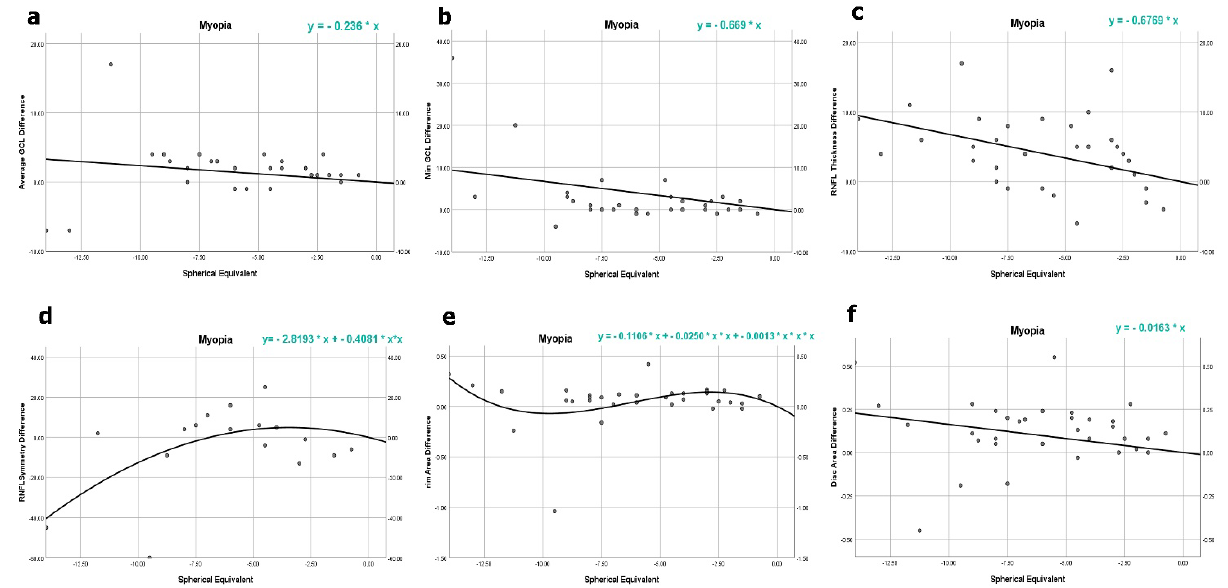
Figure 1. ( a ) Average GCL linear regression ( p < 0.04); ( b ) min GCL linear regression ( p < 0.001); ( c ) RNFL thickness linear regression ( p < 0.001); ( d ) RNFL symmetry quadratic regression ( p < 0.04); ( e ) rim area cubic regression ( p < 0.05); ( f ) disk area linear regression ( p <